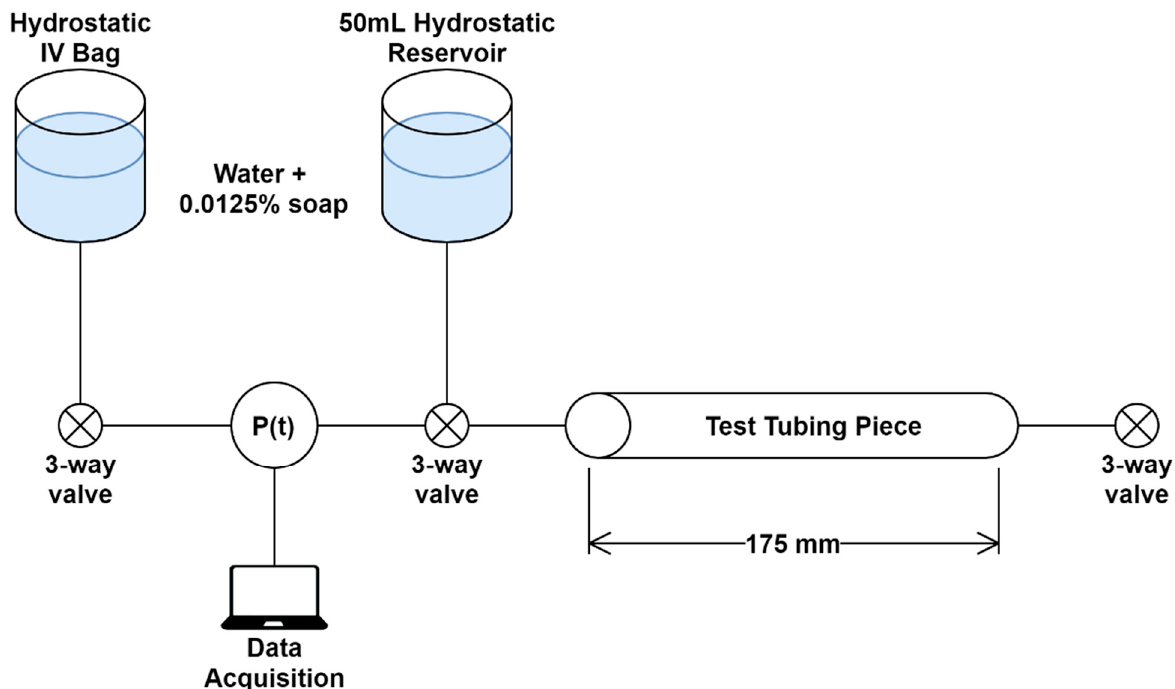
Figure 2. Overview of the tube leak testing. The test tube length was standardized at 175 mm with 3-way valves positioned on both sides to isolate the tubing piece. Two hydrostatic reservoirs were used for the system. One was a pressurized IV bag that could set the starting pressure in the system. The second was for removing air bubbles that may arise. Data was acquired by in-line pressure transducer (P(t)) and LabChart software.